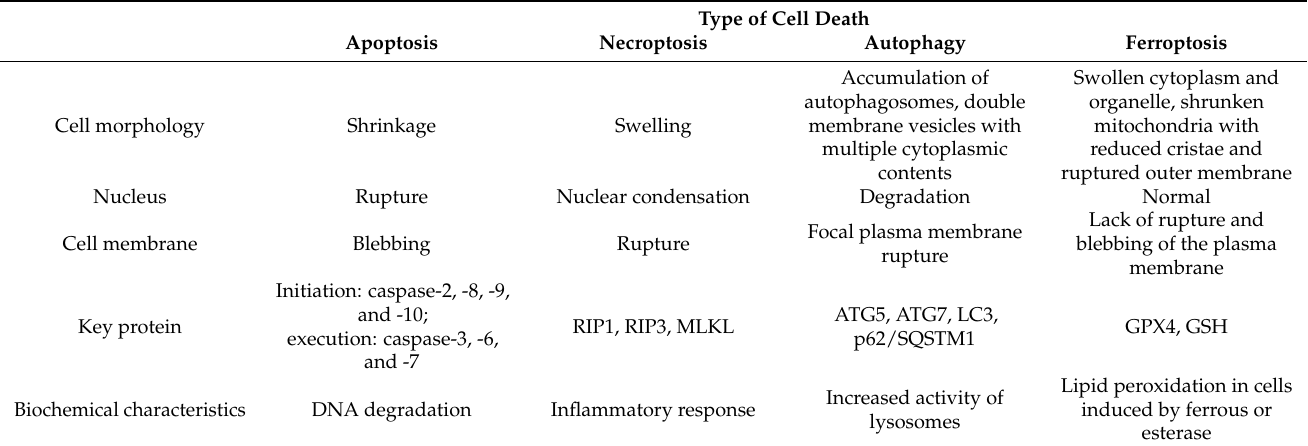
Table 1. Main features of apoptosis, necrosis, autophagy, and